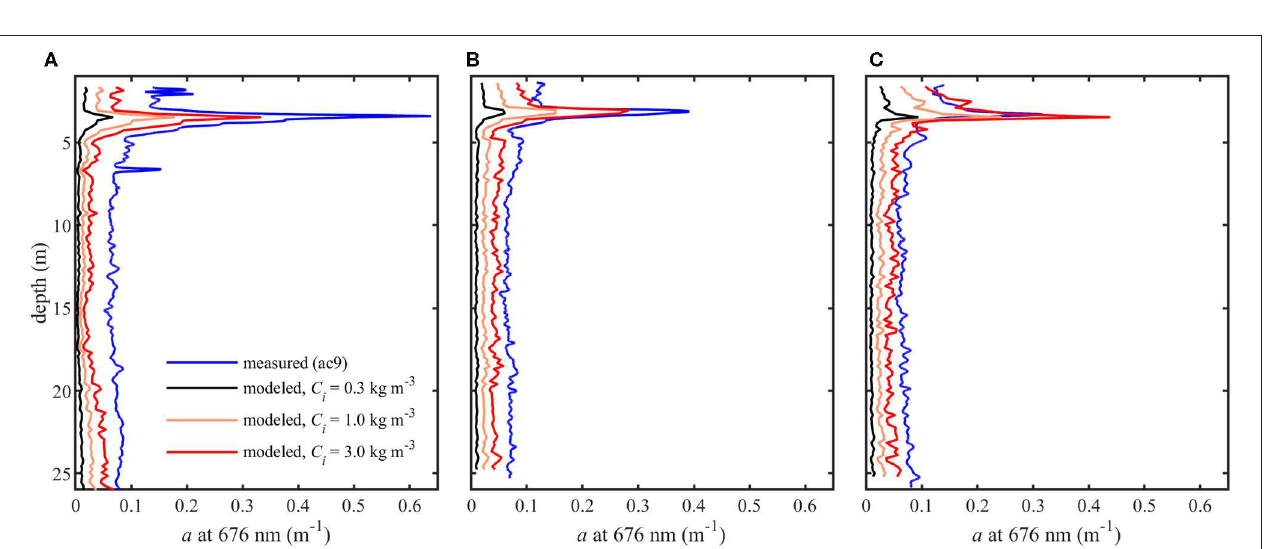
FIGURE 6 | Orientation distributions (bottom x-axis) for three profiles (A–C) and modeled change in absorption ( 1 a ph ) due to orientation (top x-axis) at 0.3, 1.0, and 3.0 kg m − 3 intracellular chlorophyll concentrations ( C i ). Color scale shows the concentration of colonies at a particular depth and orientation. Modeled 1 a ph values are the difference between measured and simulated random orientations.